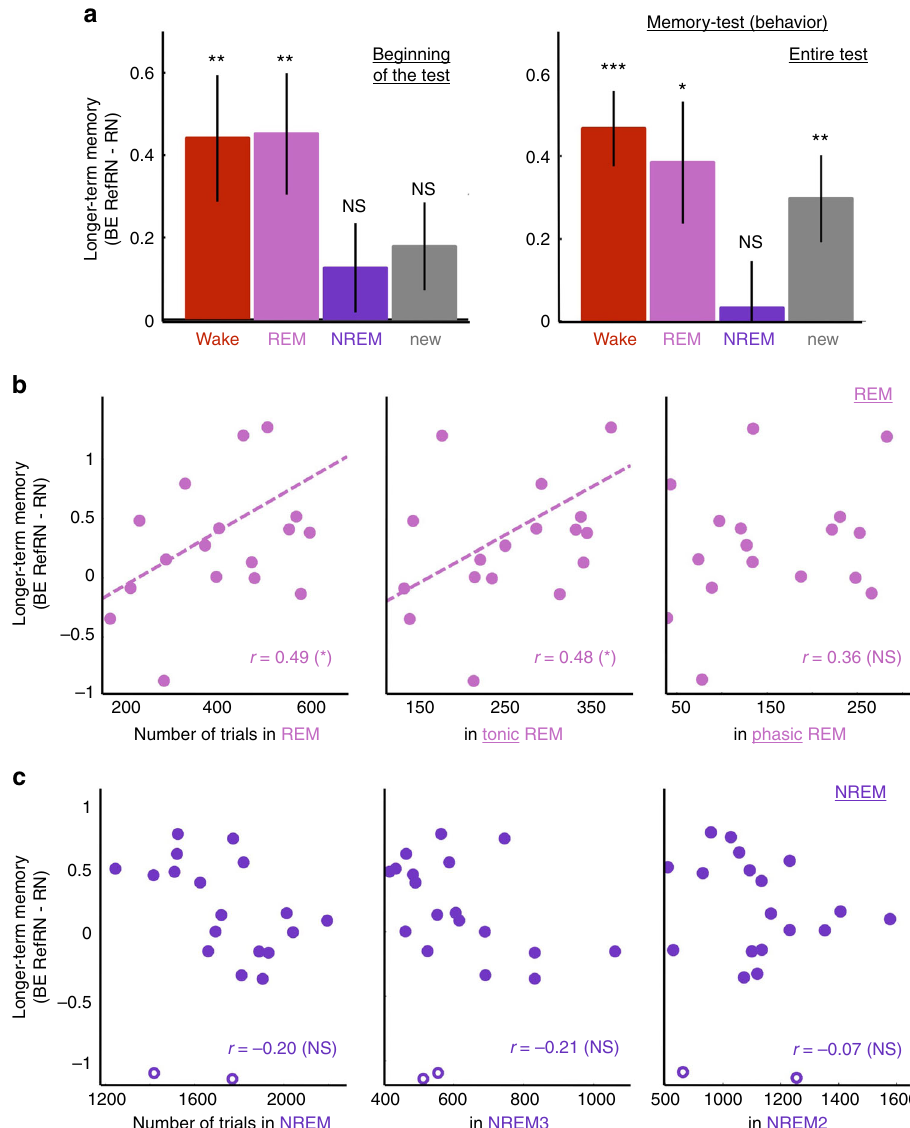
Fig. 3 Impact of prior exposure on behavioral performance upon awakening. a Behavioral ef fi cacy indexes of longer-term memory (RefRN — RN) computed for the beginning ( left , 3 fi rst trials) or the entire ( right ) post-sleep blocks. BE was computed separately for the RefRN heard during wakefulness, REM, NREM, or for the novel RefRN introduced in the post-sleep phase. Error bars denote the standard error of the mean across participants ( N = 20). Stars atop bars indicate the results of the statistical tests ( t -tests against 0, P < 0.001: ***; P < 0.01: **; P < 0.05: *, NS: P ≥ 0.05). Performance is better for RefRN sounds heard during wake and REM sleep at the beginning of post-sleep blocks. For the whole test analysis, all conditions improve as participants could learn even new RefRNs during the block, with the notable exception of RefRN sounds heard during NREM sleep: those were not learnt even after the whole test. b Correlation between the REM sleep longer-term memory index (BE RefRN — BE RN ) and the number of trials played in REM sleep ( left ), tonic REM sleep ( middle ), and phasic REM sleep ( right ) across participants. c Correlation between the NREM sleep longer-term memory index and the number of trials played in NREM sleep (NREM2+ NREM3, left ), NREM3 ( middle ) and NREM2 ( right ) across participants. For b and c , Pearson ’ s correlation coef fi cients are displayed on each correlation plot ( P < 0.05: *, NS: P ≥ 0.05). Open circles ( c ) show data points detected as outliers (see Methods). The correlation coef fi cients obtained when excluding these data points are presented in the Results section. Dotted lines show the linear fi t for pairs of variables